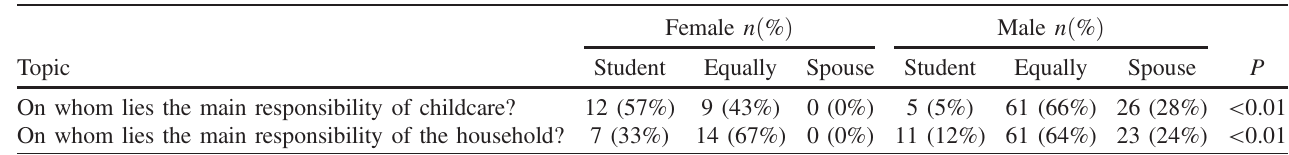
TABLE V. Results of survey on the issues of childcare and household.